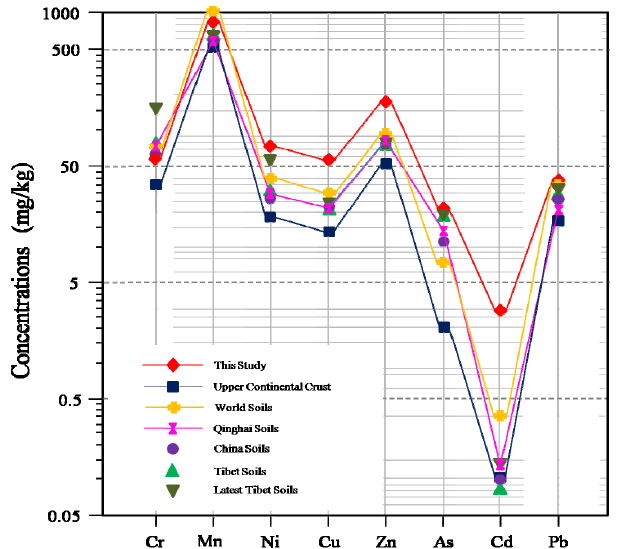
Figure 2. Comparisons of HM concentrations across different scales and regions.